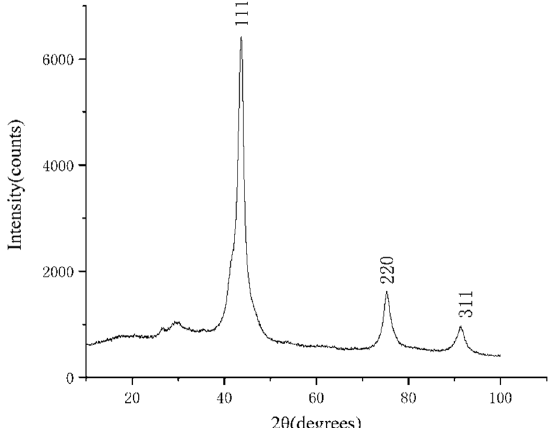
Figure 7. The XRD pattern of the purified product of the 20% PE experimental group. The horizontal coordinate indicates the diffraction angle and the vertical coordinate indicates the intensity of the diffraction peaks. The crystal planes corresponding to the three diffraction peaks are indicated.